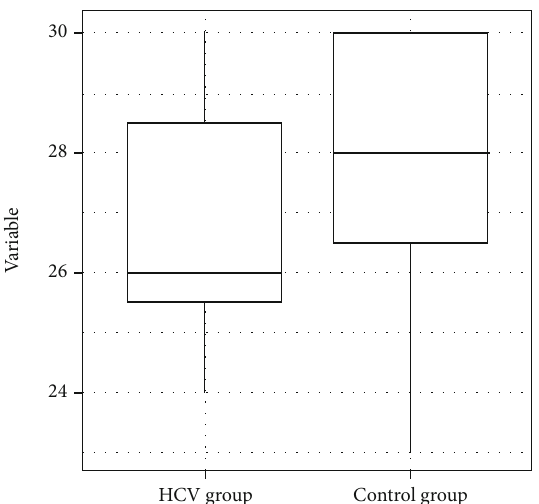
Figure 1: Distribution of the variable Mini-Mental State Examination total scores.